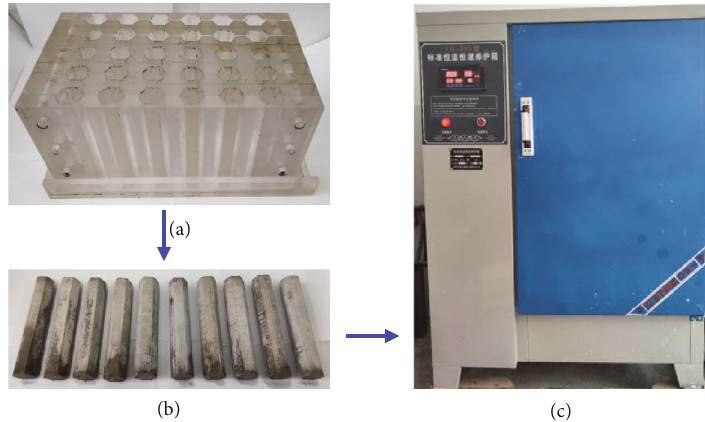
Figure 1: Mold for creating the column and the standard curing